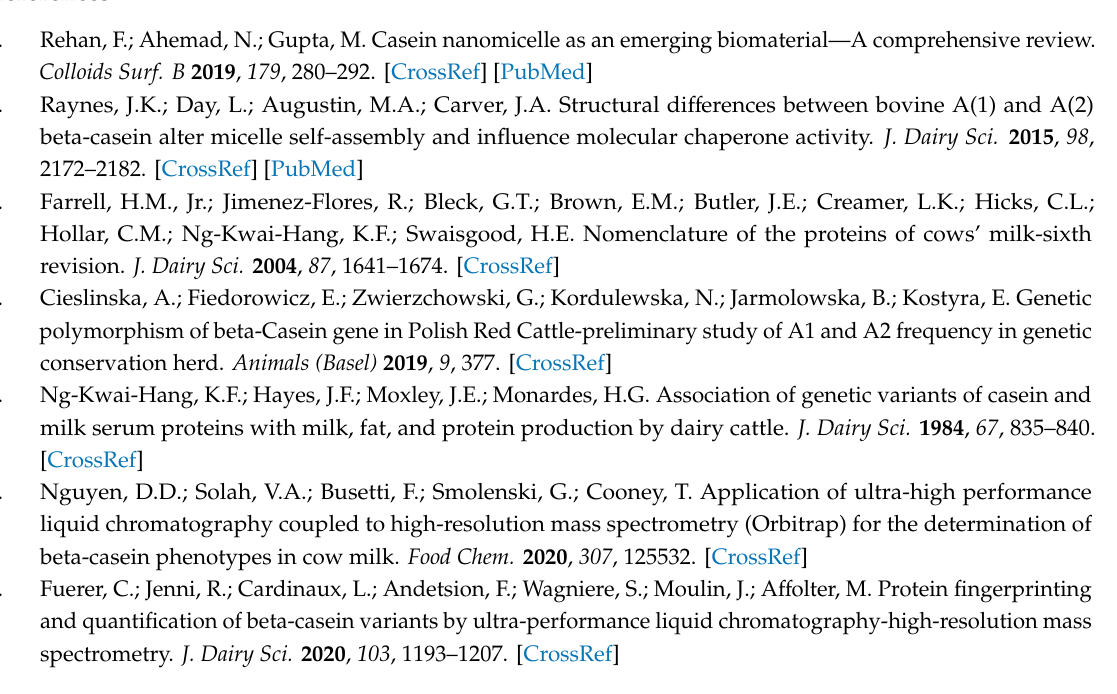
Figure S1: Representative 1H-NMR spectra region of δ 0.6–5.4 and 5.4–9.5 obtained from β -casein variants A1 / A1 (A1), A2 / A2 (A2), and heterozygote A1 / A2 (A12) milk, Figure S2: An overview of 3D principal component analysis score plots of nuclear magnetic resonance spectra signals from β -casein variants A1 / A1 (A1), A2 / A2 (A2), and heterozygote A1 / A2 (A12) milk, Figure S3: The score plots and coe ffi cient loading plots of orthogonal partial least squares discriminant analysis from nuclear magnetic resonance spectral signals between variants A1 / A1 (A1), A2 / A2 (A2), and heterozygote A1 / A2 (A12) milk, Figure S4: The total ion chromatogram of QC samples from all β -casein variants A1 / A1 (A1), A2 / A2 (A2), and heterozygote A1 / A2 (A12) milk in positive-mode (a) and negative-ion mode (b) of LC–MS, Figure S5: Pathway analysis of di ff erential metabolites between variant A1 / A1 and heterozygote milk with MetaboAnalyst software, Figure S6: Pathway analysis of di ff erential metabolites between variant A2 / A2 and heterozygote milk with MetaboAnalyst, Table S1: The information of milk samples among bovine β -casein variant A1 / A1, A2 / A2, and heterozygote milk, Table S2: The di ff erential metabolites from β -casein variants A1 / A1 and A2 / A2 or heterozygote milk in positive ion mode of LC–MS data, Table S3: The di ff erential metabolites from β -casein variants A1 / A1 and A2 / A2 or heterozygote milk in negative ion mode of LC–MS data, Table S4: The metabolic pathways of di ff erential metabolites from variants A1 / A1 and A2 / A2 milk with P values no greater than